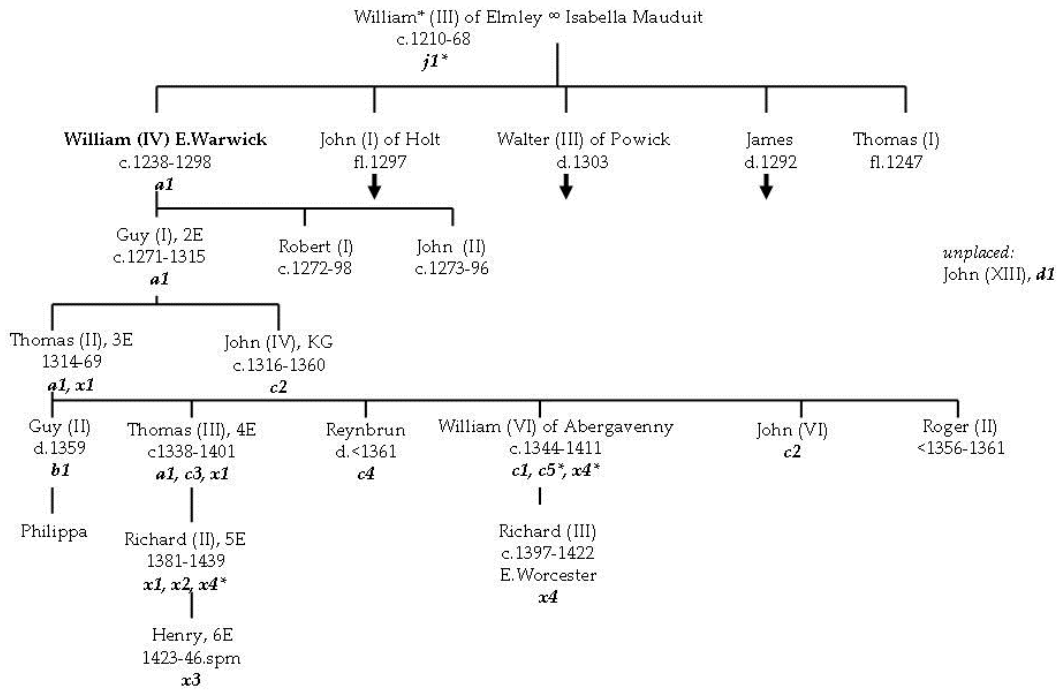
Figure 2. The branch of Beauchamp of Warwick; * problematic assignments; a1–x3 arms as in Figure 1.